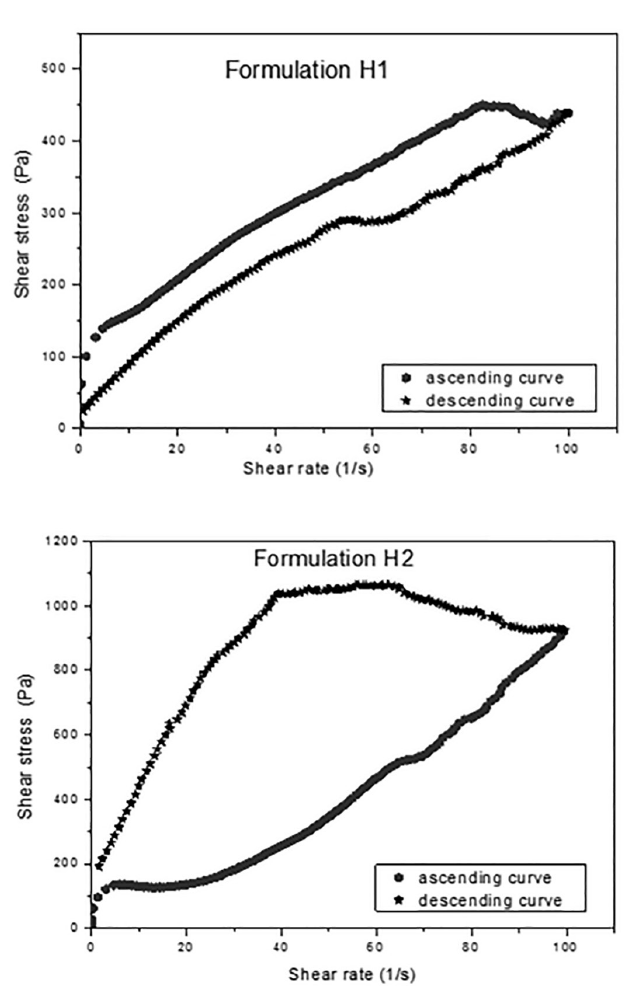
FIGURE 4 - Flow curve of formulations H1 and